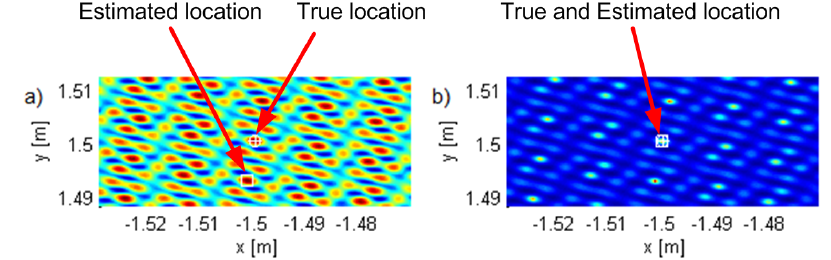
Figure 4. The criterion functions for G 5 and T 2 for ( a ) ML-US (magnitude in linear scale) and ( b ) SCM-MUSIC (magnitude in logarithmic